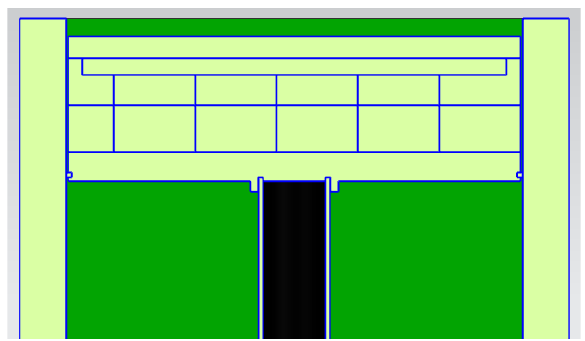
Figure 17. Side view of HeatGenPro concept.